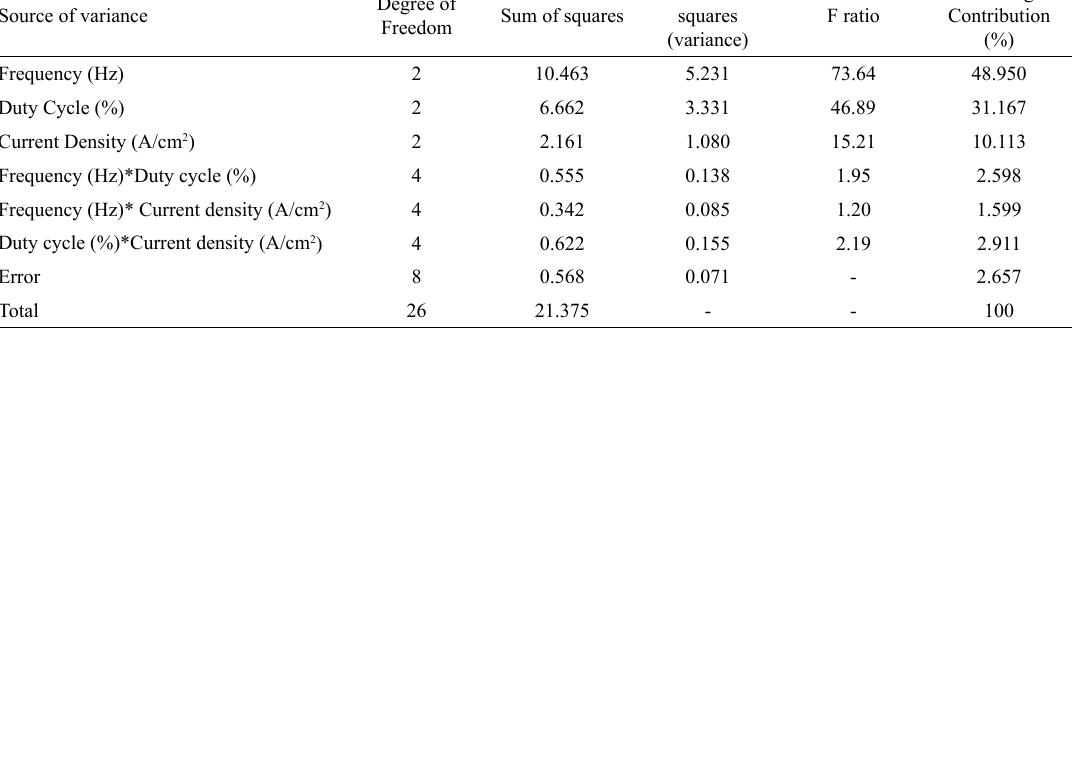
Table 5. Results for the ANOVA for the microhardness of Ni/nano-Al Source of variance